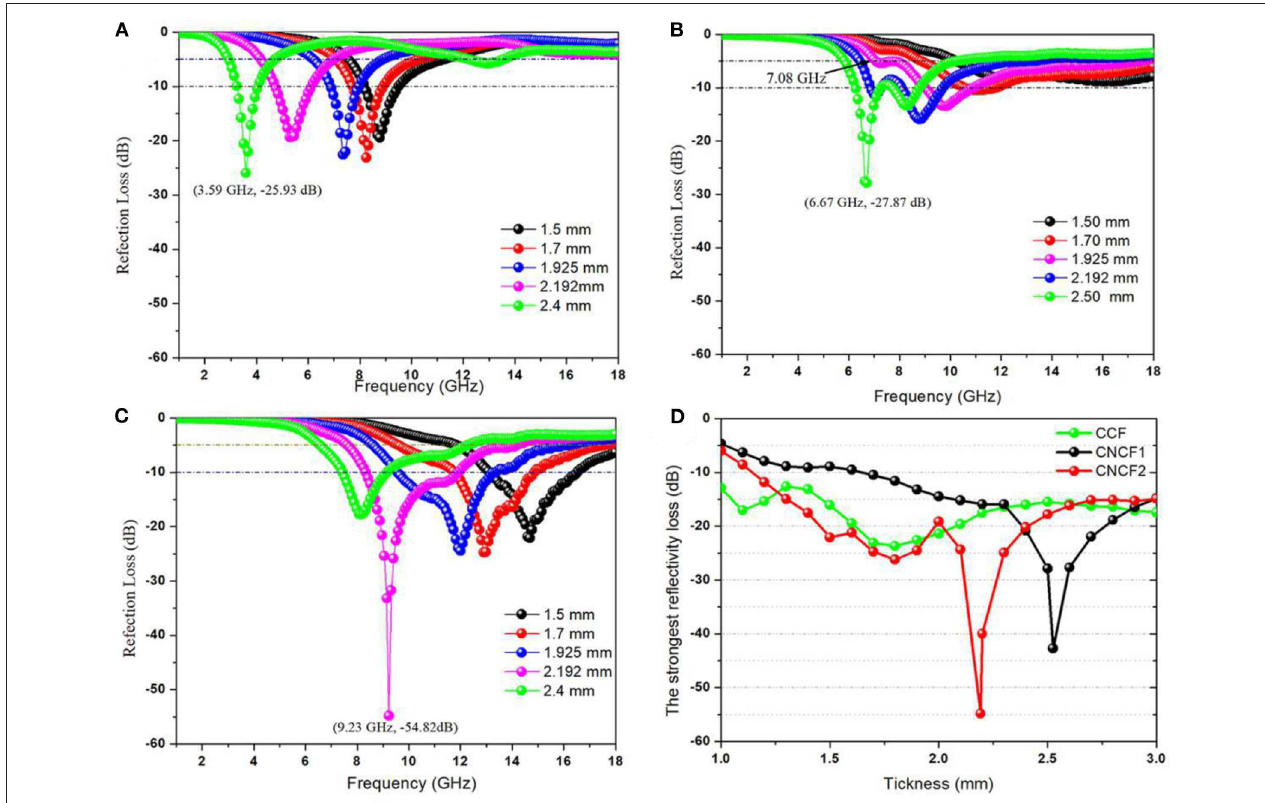
FIGURE 6 | RL (dB) calculated for CCF (A) , CNCF1 (B) , and CNCF2 (C) composites; the strongest RL (D) of CCF and CNCF1-2 composites with different thicknesses.